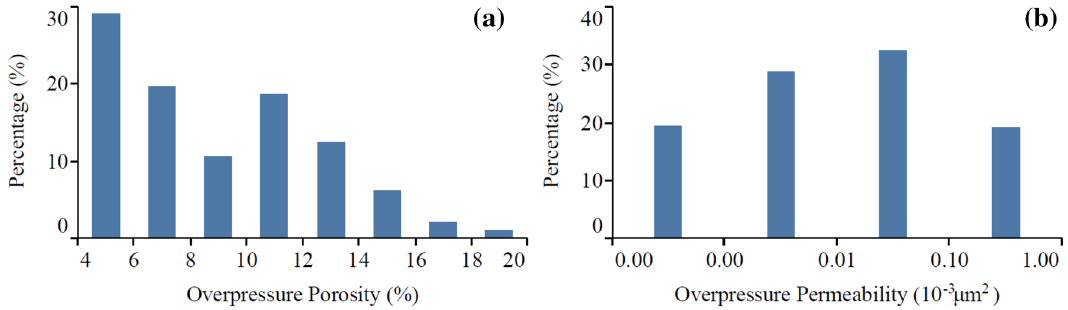
Fig. 5 Overpressure porosity ( a ) and permeability ( b ) distribution of reservoirs in the Lucaogou